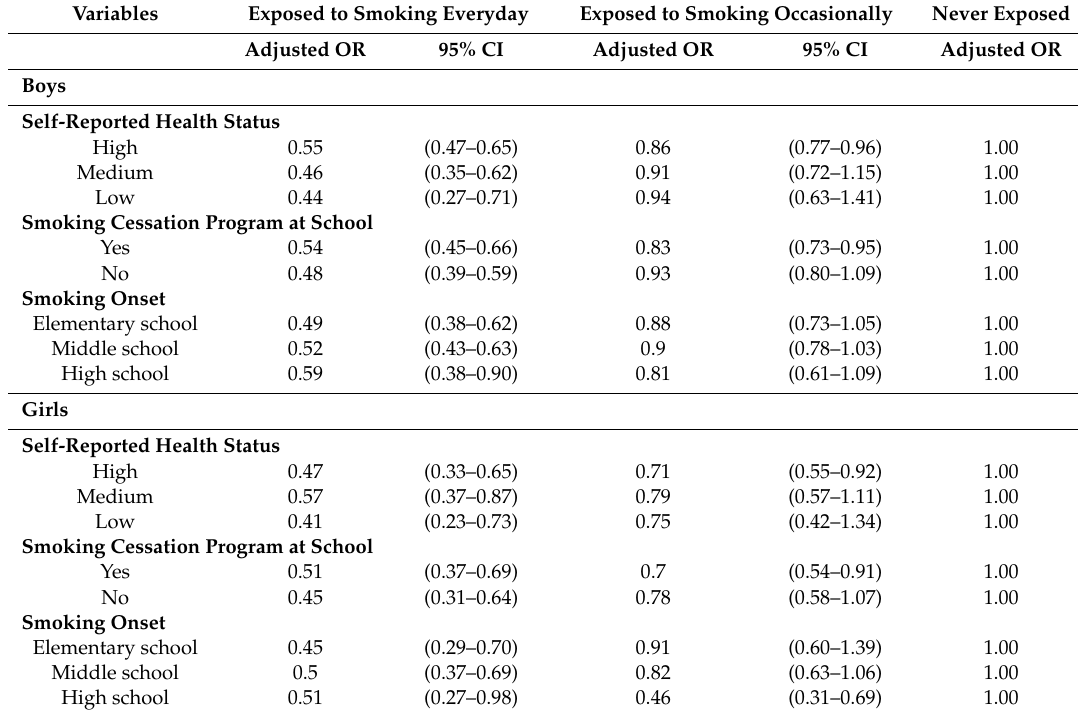
Table 3. Subgroup analysis representing the odds ratios for attempts to quit smoking, stratified by smoking exposure at